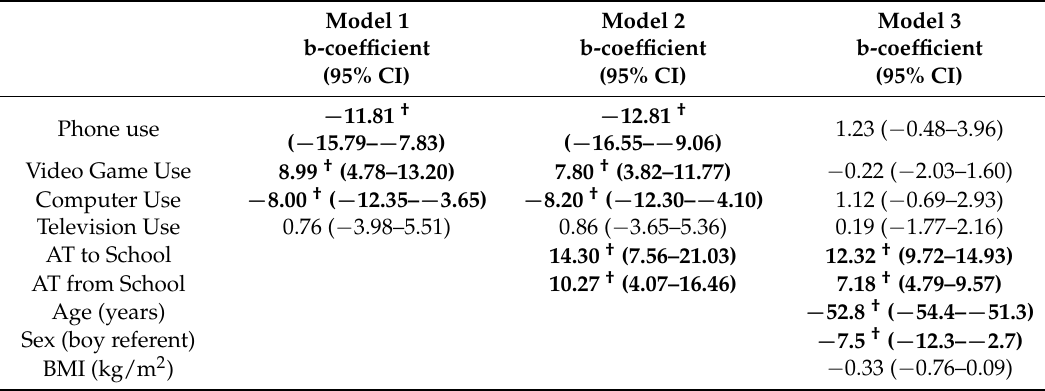
Table 2. Parameter estimates from the weighted multiple linear regression